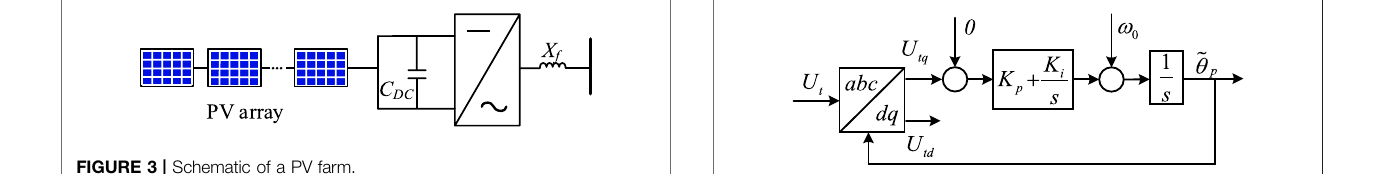
FIGURE 3 | Schematic of a PV farm.